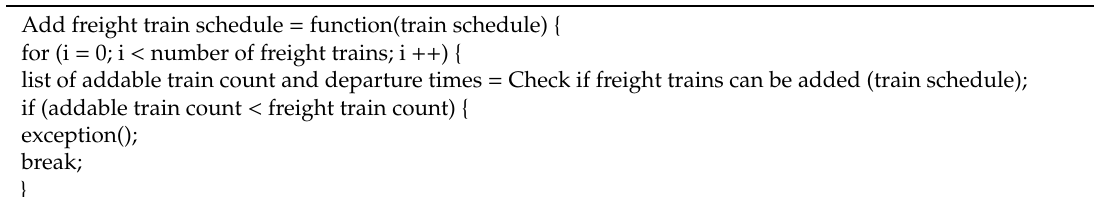
Table 7. Pseudocode for an array of departure time for the freight train